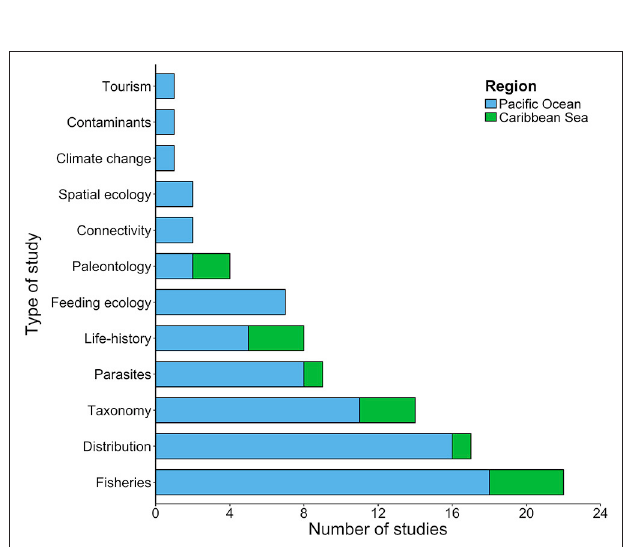
FIGURE 3 | Number of studies (scientific publications, theses, technical reports, and books) by topic conducted in the Pacific Ocean and Caribbean Sea of Costa